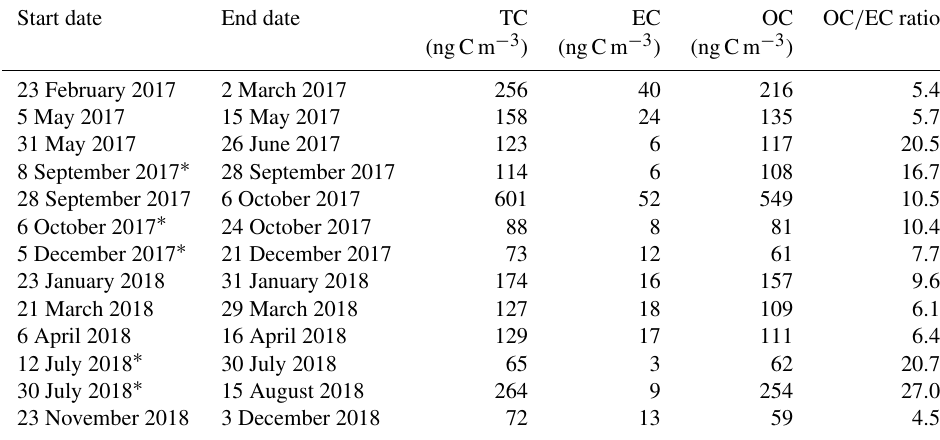
Table 1. OC / EC ratios and filter loadings measured by NILU using the EUSAAR_2 protocol. Filters that were pooled for 14 C analysis are marked with an asterisk.